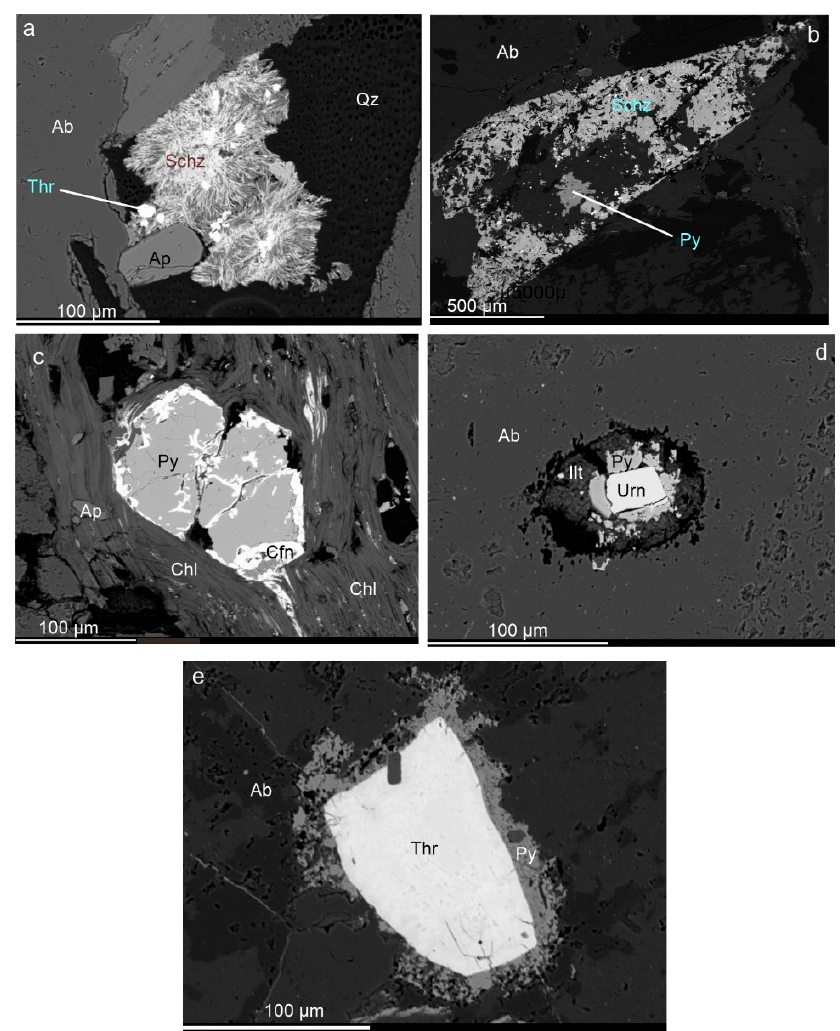
Figure 8. Back-scattered electron (BSE) images of coffinite, synchysite, thorite, and uraninite occurring in hydrothermally altered granodiorites (Ab—albite, Ap—apatite, Cfn—co ffi nite, Chl—chlorite, Ilt—illite, Qz—quartz, Py—pyrite, Schz—synchysite, Thr—thorite, and Urn—uraninite), ( a )—Nahoš í n uranium deposit, sample R-710; ( b )—Meˇcichov uranium deposit, sample R-784; ( c )—Nahoš í n uranium deposit, sample R-752; ( d )—Nahoš í n uranium deposit, sample R-710; and ( e )—Meˇcichov uranium deposit, sample